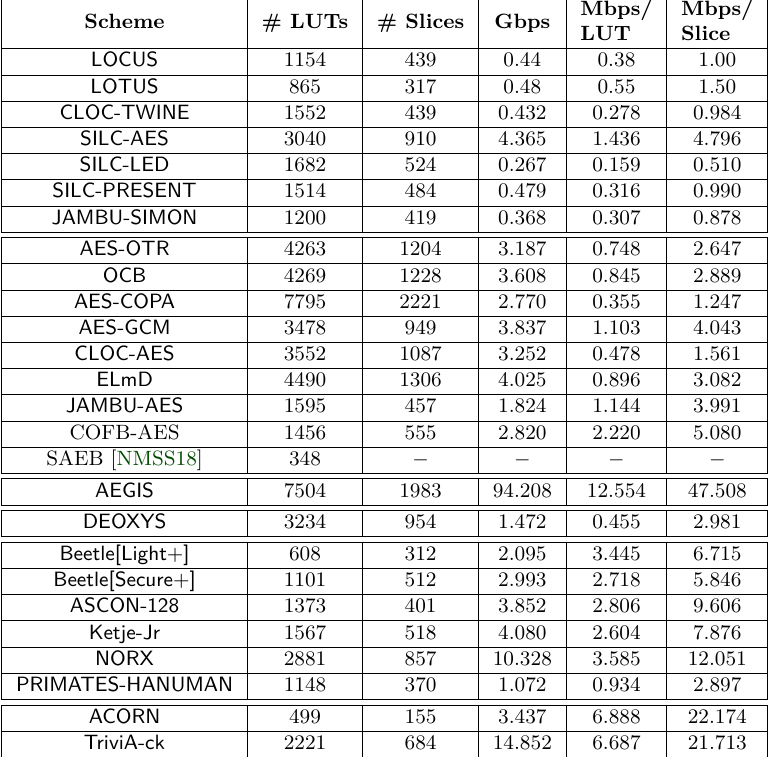
Table 7: Comparison on Virtex 7